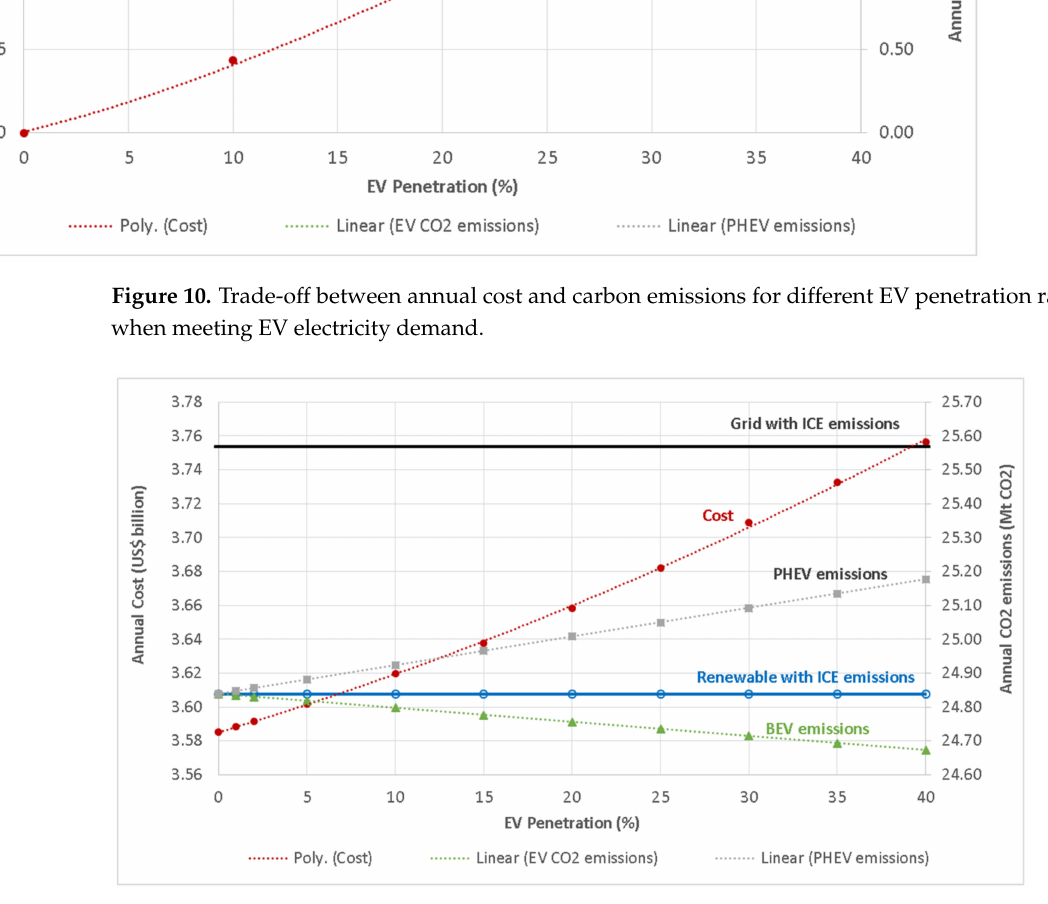
Figure 11. Trade-off between annual cost and carbon emissions for different EV penetration ratios when meeting both EV and Abu Dhabi electricity